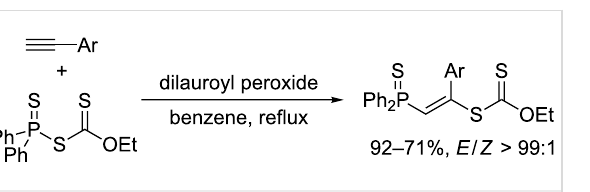
Scheme 9: Mechanism of thiophosphination with diphenyl(organosul- fanyl)phosphine.